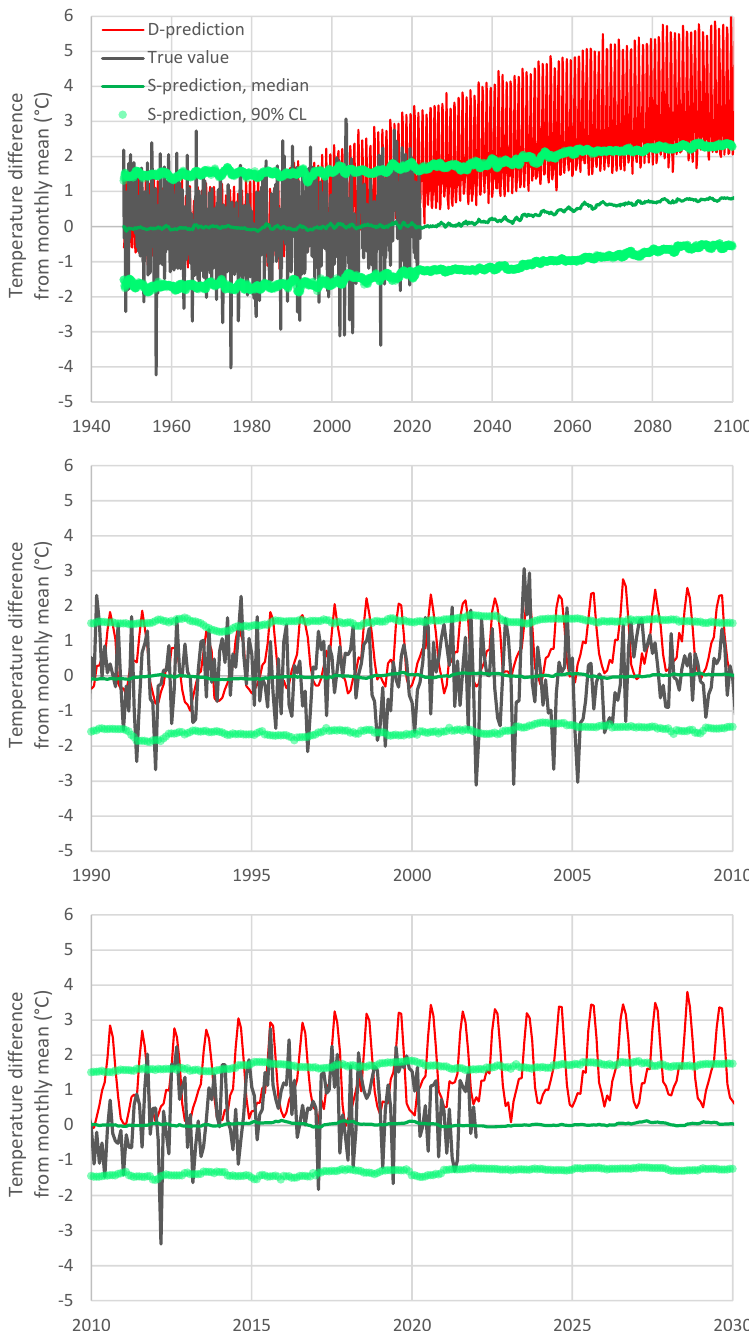
Figure 6. As Figure 5, but with S-model results (median and 90% confidence limits) replaced by running averages over 12 months.